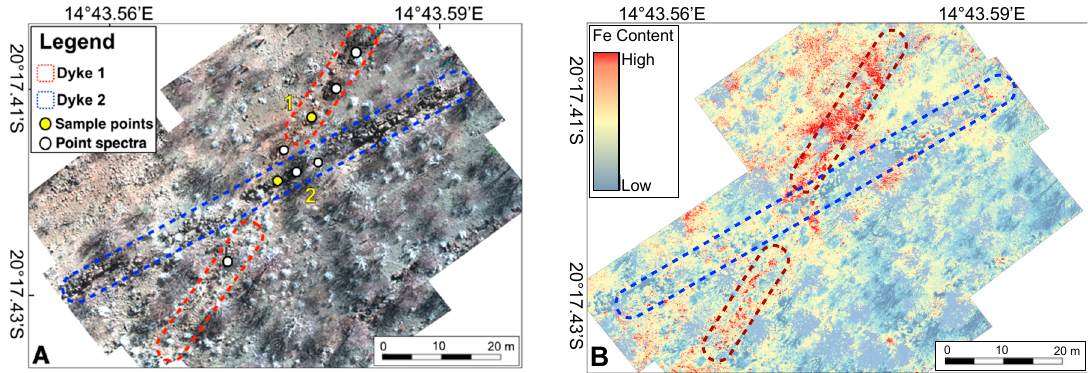
Figure 12. ( A ) RGB hyperspectral mosaic showing the two types of dykes. The locations of point spectra and rock sampling are shown. ( B ) Image showing the result of band ratio 760 / 503 enhancing the iron feature.